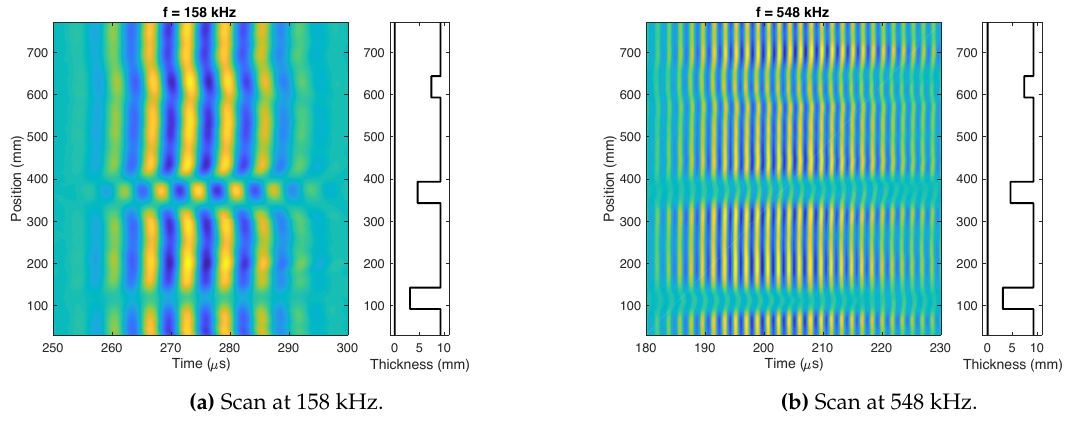
(b) Scan at 548 kHz.